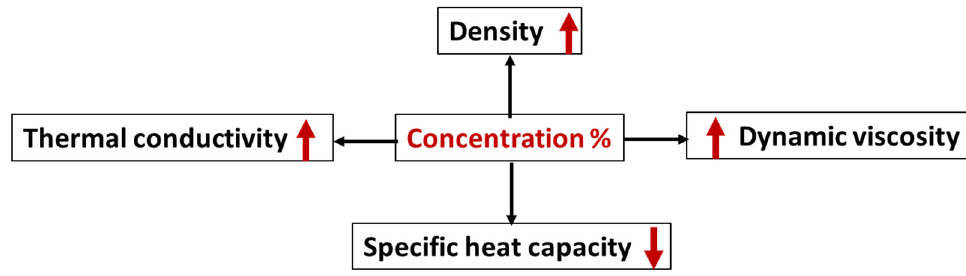
Figure 3. Influences of an increase in nanoparticle concentration in a base fluid on nanofluid prop- erties.